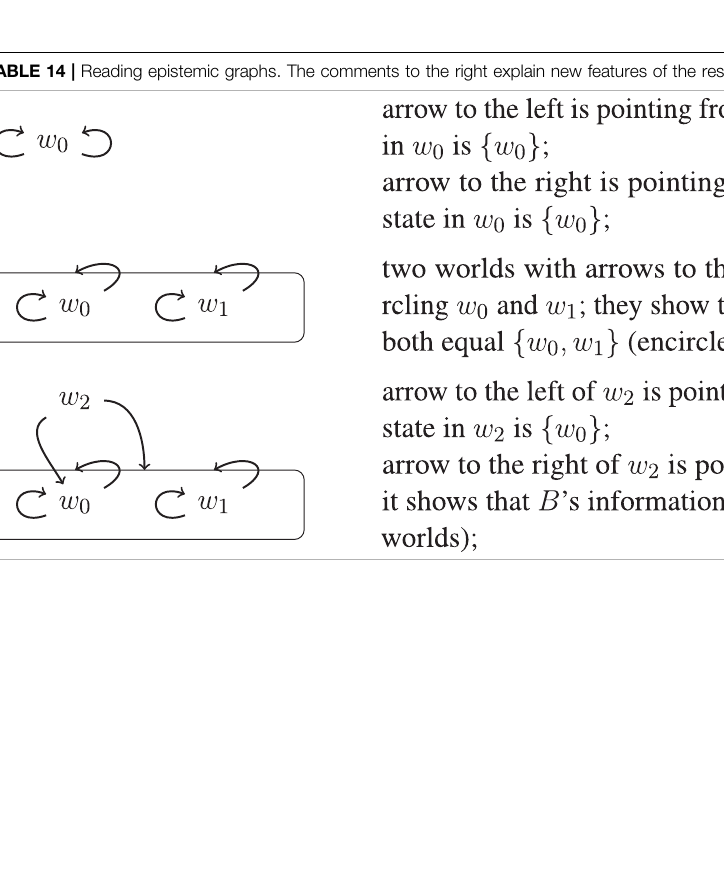
Frontiers in Communication |